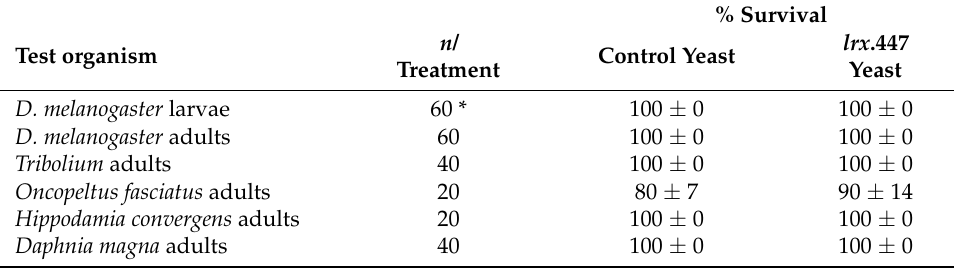
Table 2. Viability of nontarget arthropods following consumption of Irx .447